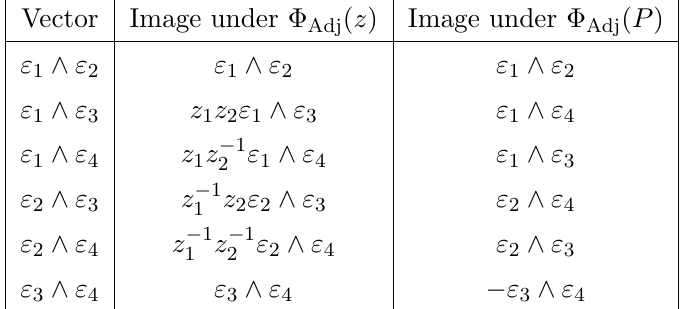
Table 5 . Detail of the computation of (cid:8) Adj ( z ) and (cid:8) Adj ( P ) in O(4). Vector